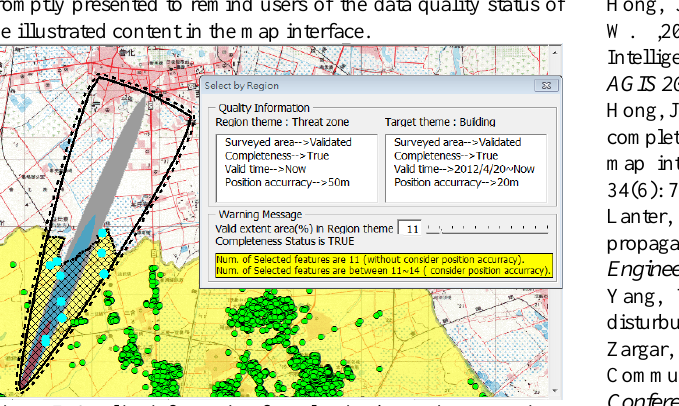
Figure 7: Quality information for selection by region